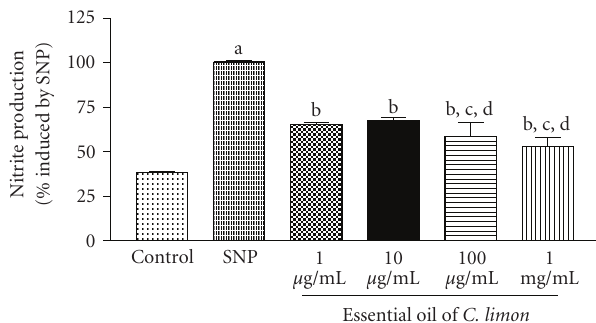
Figure 3: Nitric oxide (NO) scavenging assay. Nitric oxide is generated from spontaneous decomposition of sodium nitroprus- side (SNP) and interacts with oxygen to produce nitrite ions, which are measured by the Griess reaction. SNP group is sodium nitroprusside alone other groups denote nitrite production by SNP in the presence of di ff erent concentrations of EO. Bars represent mean ± SEM. a P < . 001, when compared to control; b P < . 001, when compared to 1 μ g/mL; c P < . 001, when compared to 10 μ g/mL; d P < . 001, when compared to 100 μ g/mL. One-way ANOVA followed by Tukey’s multiple comparison post hoc test was applied to all data.